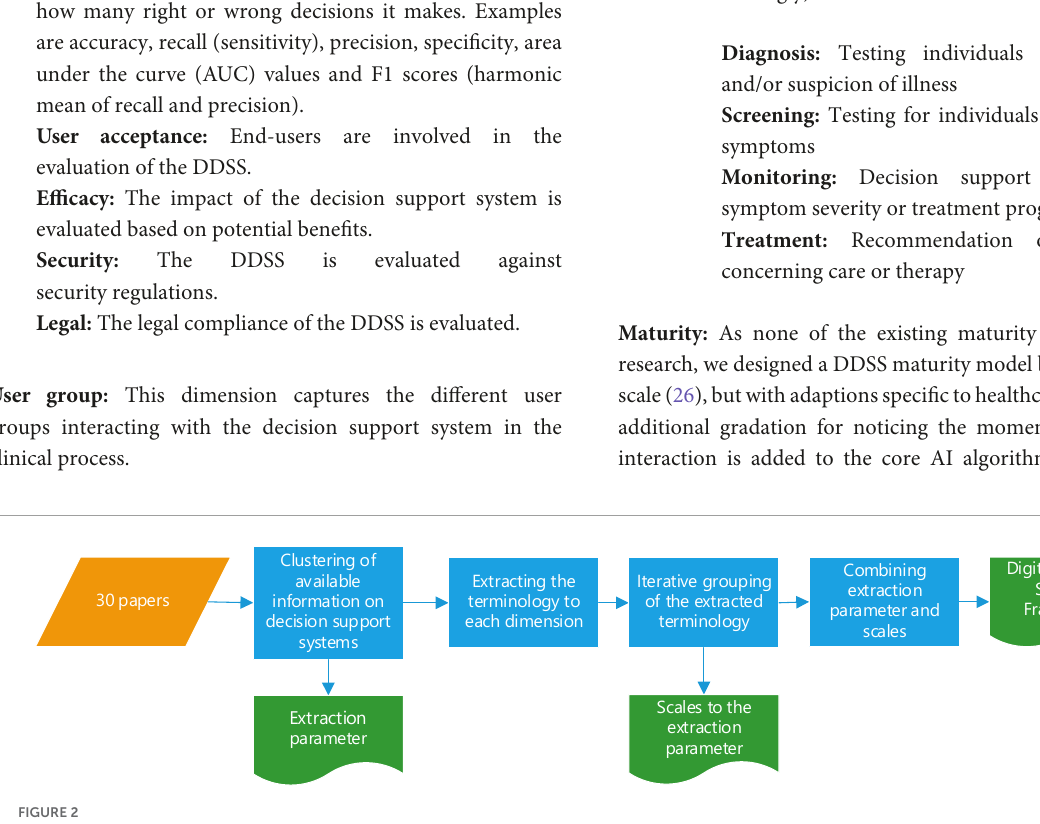
FIGURE2 Extraction